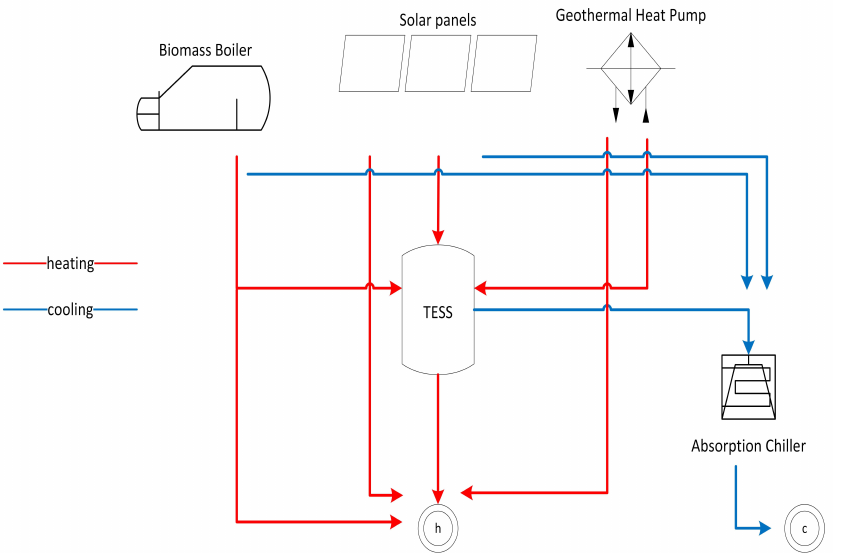
Figure 3. MGM representation of the system